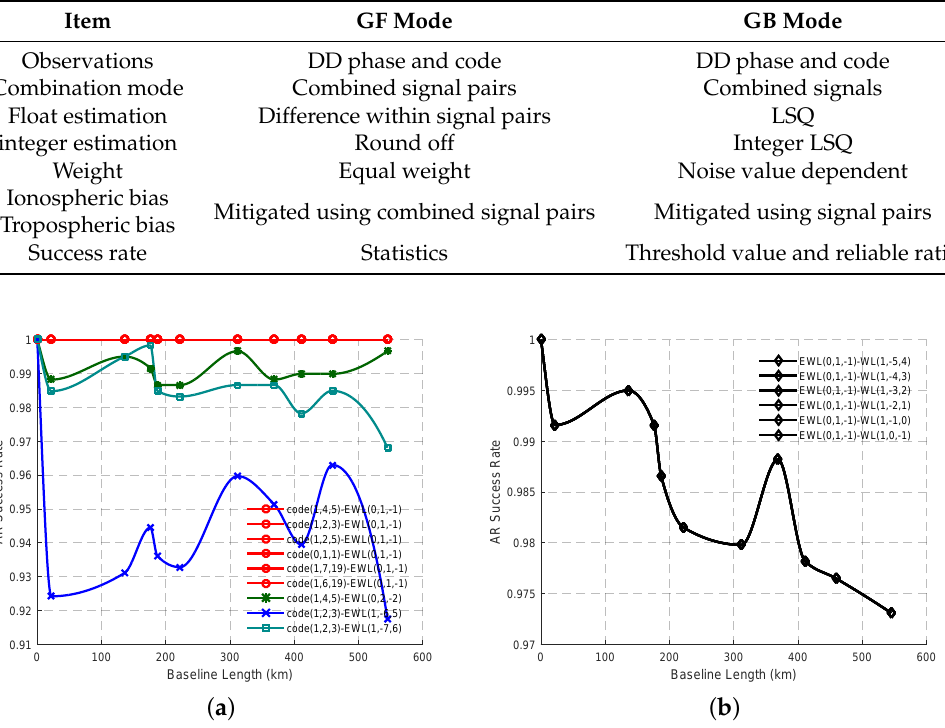
Table 8. Triple-frequency data processing strategy and estimated parameters.